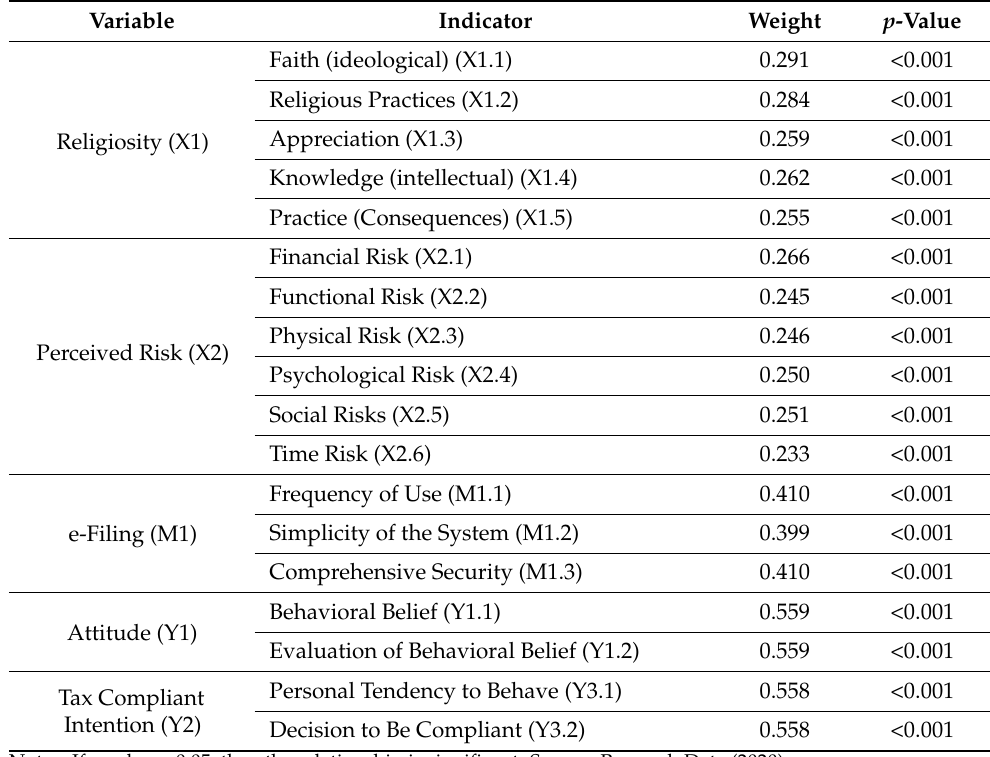
Table 3. Measurement model.